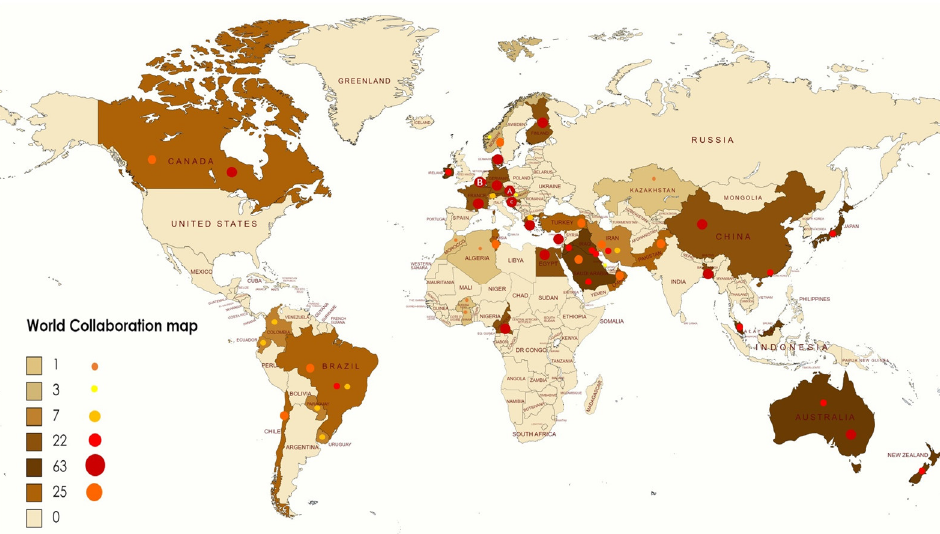
Figure 5. World map of collaboration.